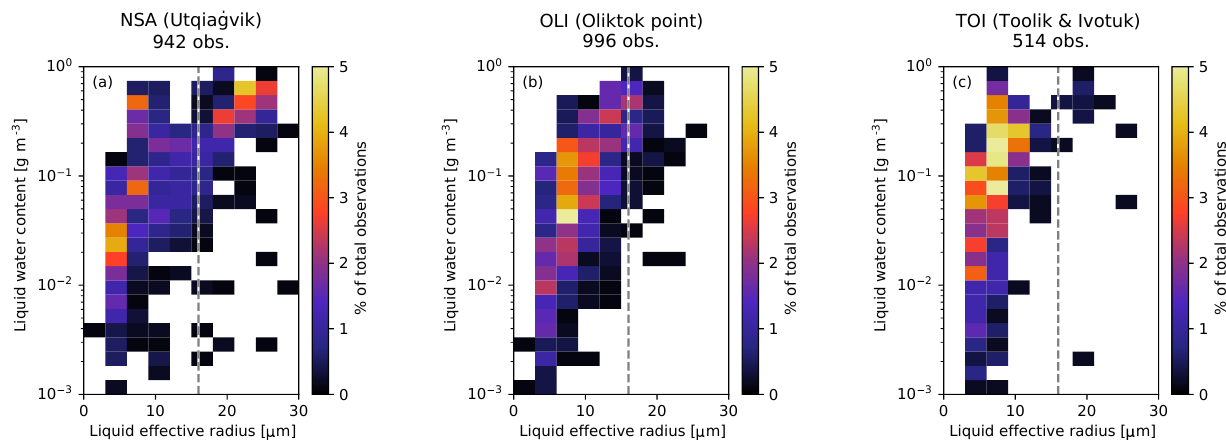
Figure 4. Two-dimensional histogram of number of observations as a function of effective radius r eff and liquid water content LWC for NSA (Utqia˙gvik/Barrow) (a) , OLI (Oliktok Point) (b) , and TOI (Toolik/Ivotuk) (c) . The dashed line indicates a r eff value of